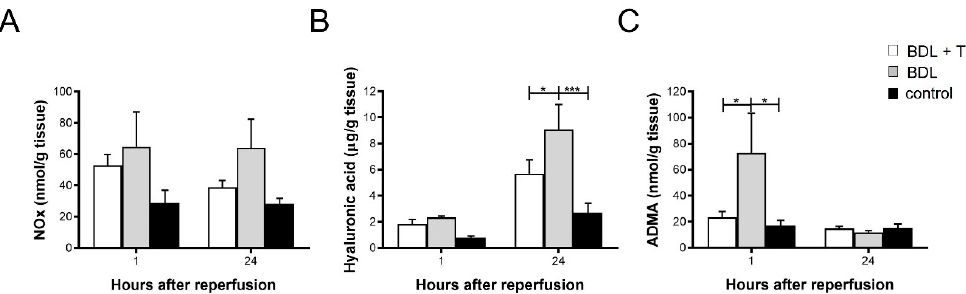
Asymmetric dimethylarginine (ADMA) levels in liver tissues were evaluated 1 h and 24 h after reperfusion. Mean and standard deviation are shown in each group with significance levels of * p < 0.05 and *** p <